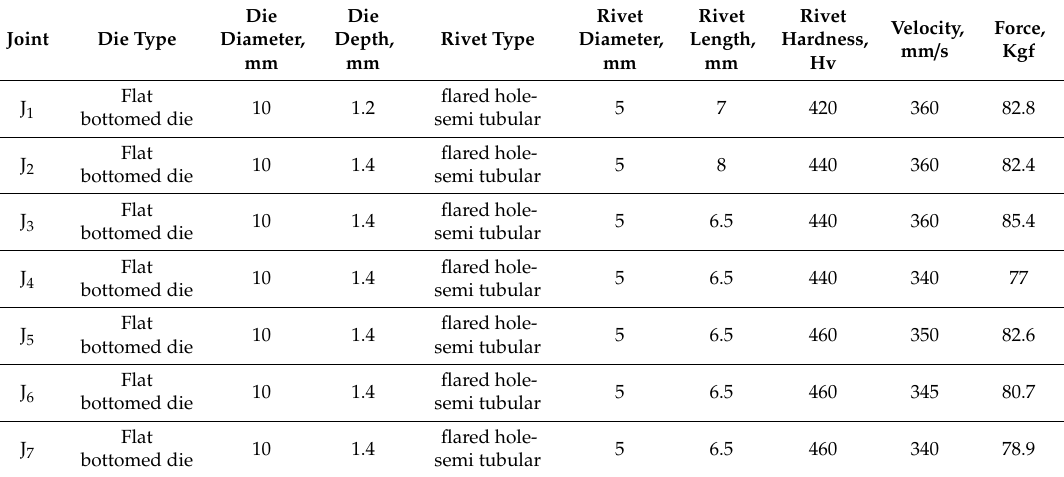
Table 3. SPR parameters for the acceptable joints.